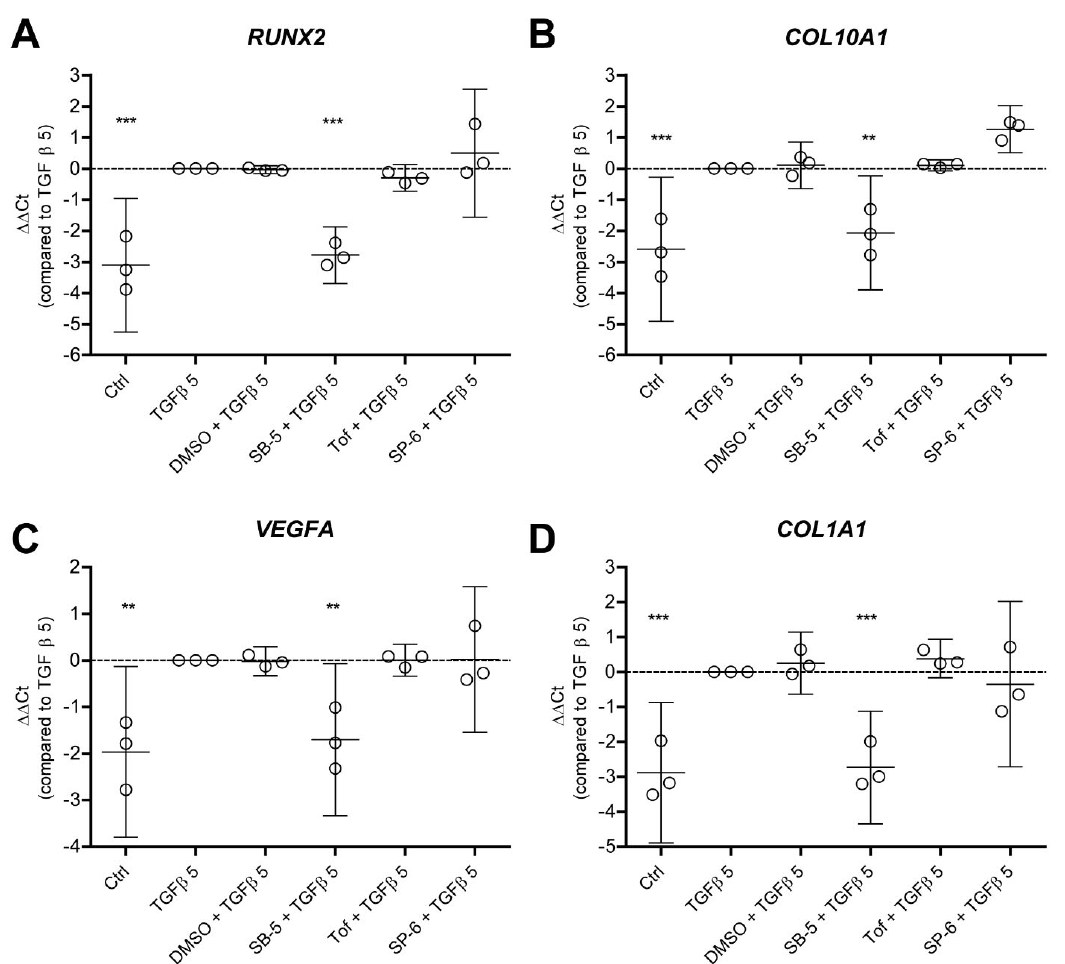
Figure 4. A hypertrophy ‐ like phenotype in OA chondrocytes, induced by TGF ‐β , is dependent on ALK5 and is not reliant on JAK and JNK. Elevated levels of TGF ‐β that are comparable to those in synovial fluid of OA patients induce expression of hypertrophic factors in human OA chondrocytes of three different donors. This is defined by increased mRNA expression of ( A ) runt ‐ related transcription factor 2 (RUNX2), ( B ) relative collagen type 10 ( COL10A1 ), ( C ) vascular endothelial growth factor A ( VEGFA ) and ( D ) alpha ‐ 1 collagen type 1 ( COL1A1 ) after stimulation with 5 ng/mL TGF ‐β 1 for 48 h. Specific pathway inhibitors were used to target the SBE, SIE and AP1 pathways, which were also activated by these levels of TGF ‐β . Cells were pre ‐ incubated with 5 μ M SB ‐ 505124 (SB ‐ 5: ALK5 kinase activity inhibitor), 1 μ M Tofacitinib (Tof: JAK inhibitor) or 10 μ M SP ‐ 600125 (SP ‐ 6: JNK inhibitor) before stimulation with 5 ng/mL TGF ‐β 1. Only blocking ALK5 kinase activity with SB ‐ 5 prevented the effect of TGF ‐β on hypertrophy genes, whereas inhibition of JAK and JNK did not. Data are plotted as mean ± 95% CI with each dot representing the average of three technical replicates in one chondrocyte donor (total of 3 different chondrocyte donors were used). Statistical analysis was performed using repeated measures one ‐ way ANOVA with Bonferroni’s post hoc test: ** p ≤ 0.01; *** p < 0.001.